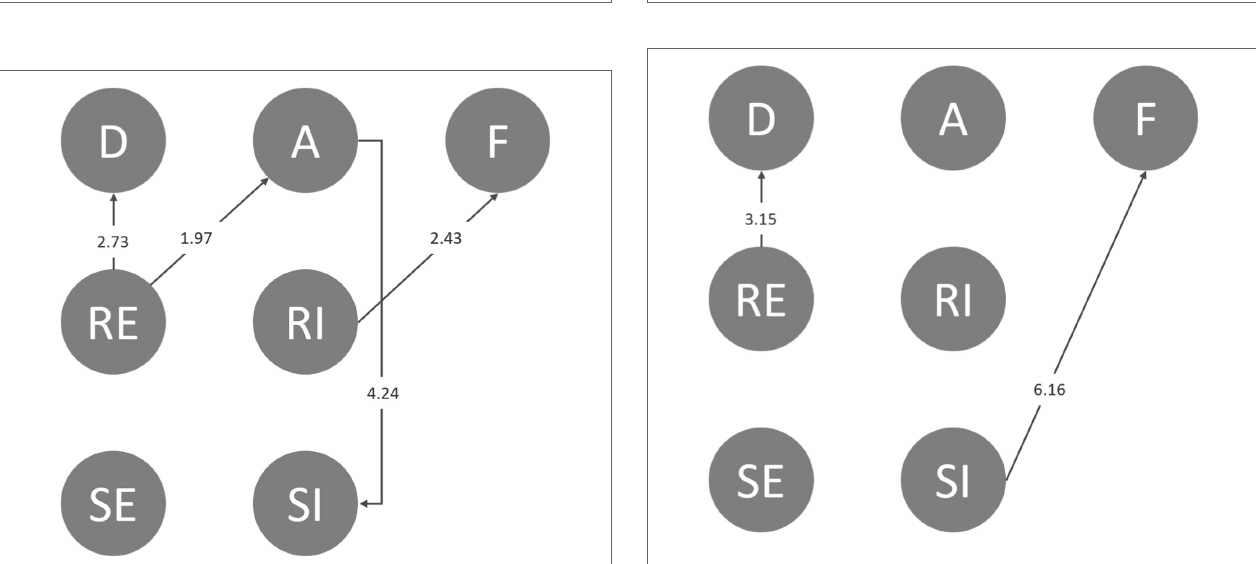
FIGURE 9 | Behavioral transition diagram of openness to experiences.